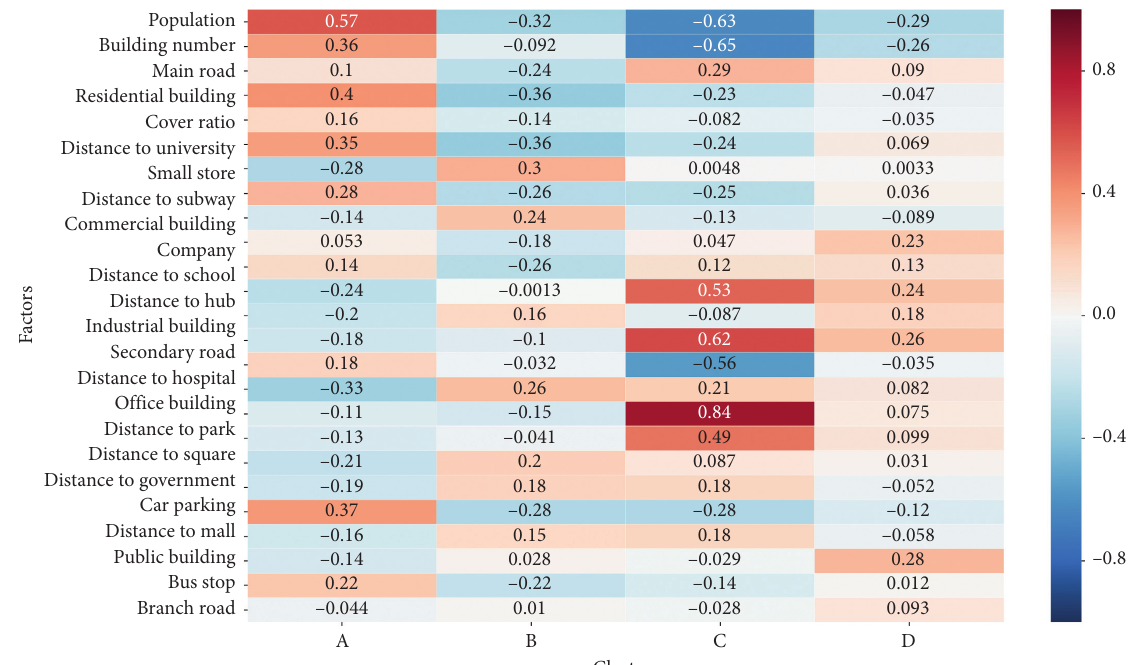
Figure 8: The heatmap of factor in four clusters.